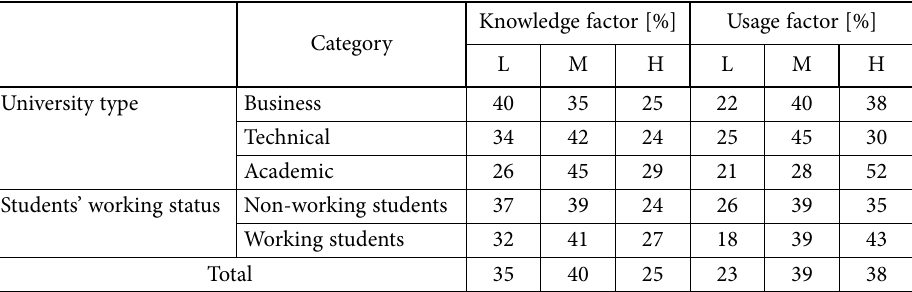
Table 2. Respondents’ characteristics in different subgroups according to knowledge and usage factors Knowledge factor [%] Usage factor [%] Category L M H L M H University type Business 40 35 25 22 40 38 Technical 34 42 24 25 Students’ working status Non-working students 37 39 Working students 32